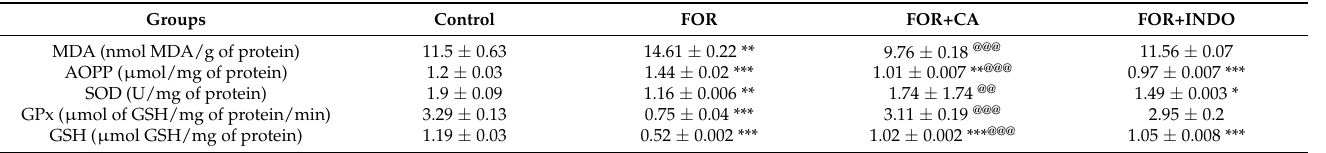
Table 5. The oxidative stress markers, SOD and GPx antioxidant activities and GSH levels in paw tissue homogenate of control and treated